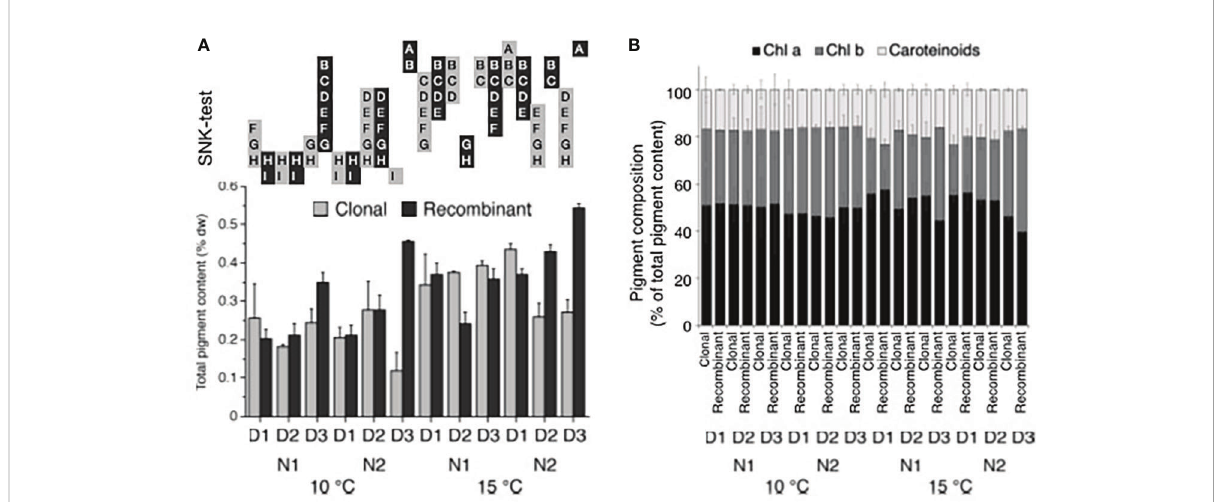
FIGURE 7 Ulva pigment content and composition. (A) Total pigment content (% dw) and (B) the distribution of chl a, chl b, and carotenoids in Ulva fenestrata clonal and recombinant gametophytes after 12 weeks culture under different environmental conditions (10°C and 15°C, N1 = PES and N2 = 3xPES, D1 = 10 000 swarmers ml -1 , D2 = 5000 swarmers ml -1 and D3 = 500 swarmers ml -1 , for further explanations see text). Letters above bars denote signi fi cant differences based on the Student Newman Keul´s (SNK) post hoc test. Treatments with non-overlapping letters are signi fi cantly different (SNK, p < 0.05). Error bars show + SEM (n =